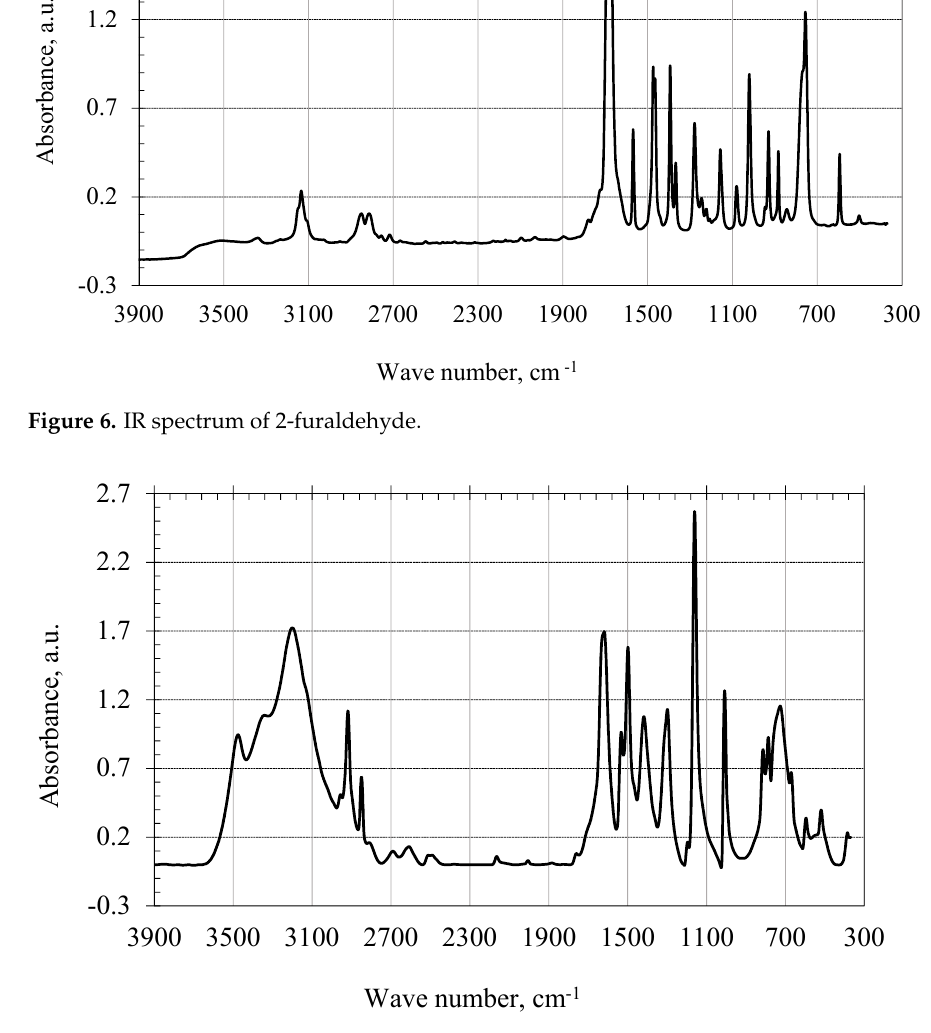
Figure 7. IR spectrum of 1,3,5-trihydroxybenzene.